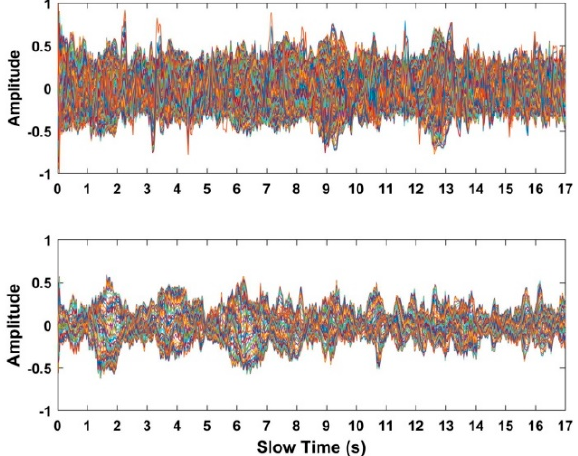
Figure 8. The acquired data from one human being at a distance of 12 m.